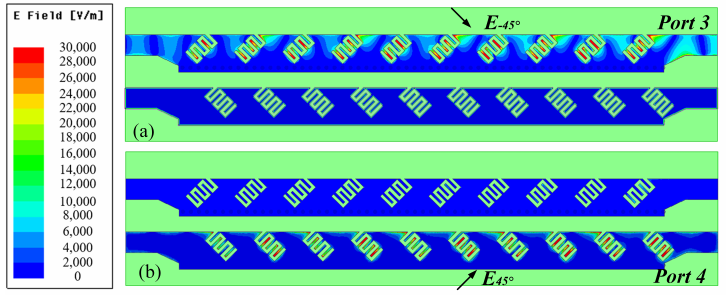
Figure 10. The electric field distribution under ( a ) Port 3 or ( b ) Port 4 excitation, respectively.